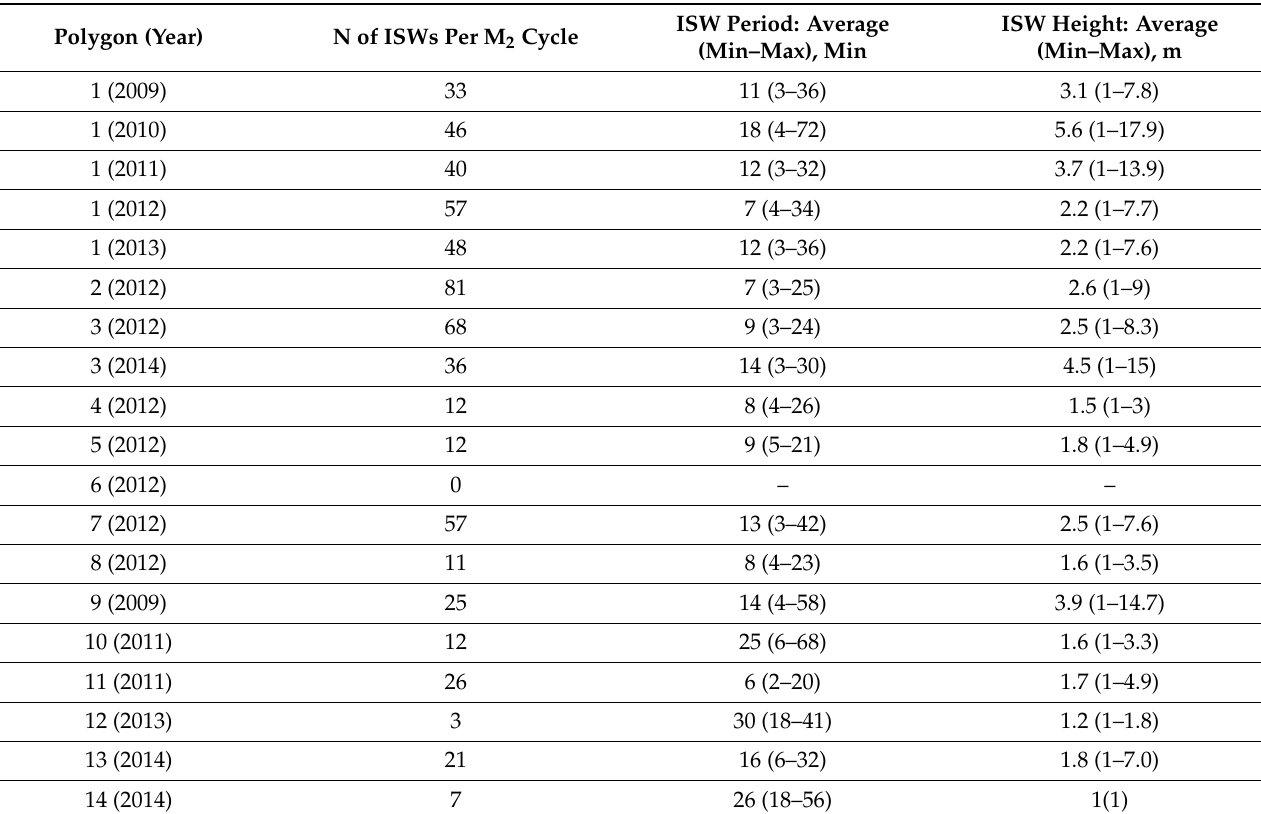
Table 2. Statistics of ISW properties in the White Sea recorded at polygons 1–14 in